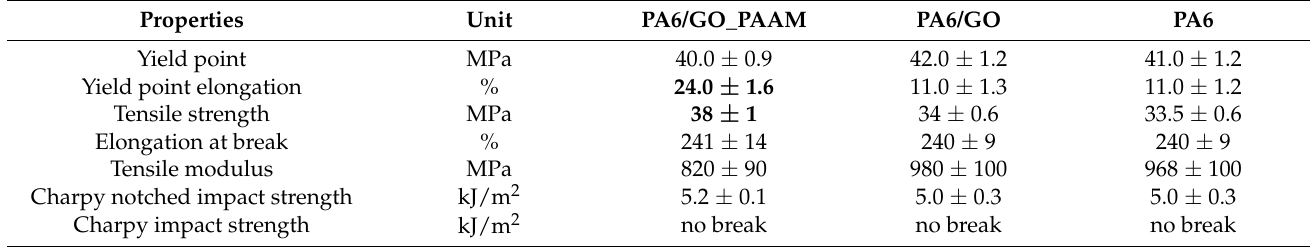
Table 1. Mechanical properties of the PA6/GO_PAAM and PA6/GO nanocomposites and parent PA6. (Numbers in bold indicate significant differences).